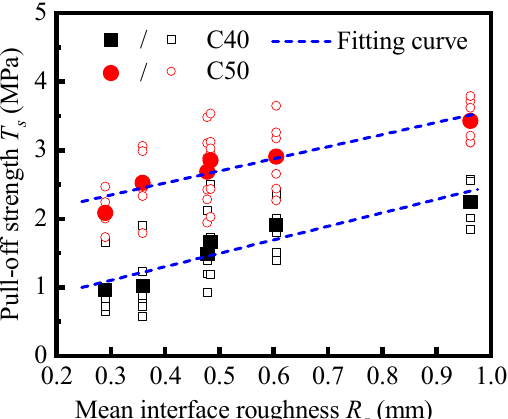
Figure 12. Relationship between pull-off strength and interface roughness R a .